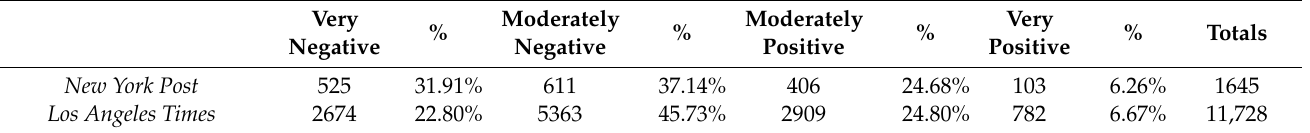
Table 1. Sentiment analysis, articles on government contracting in the New York Post and Los Angeles Times ,